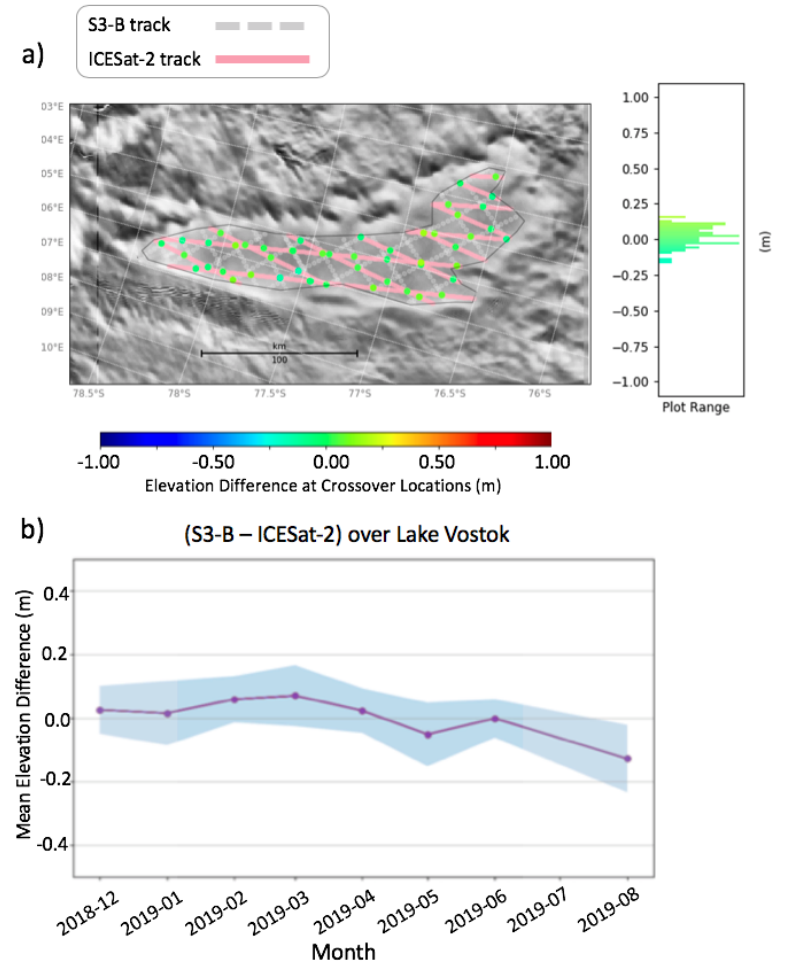
Figure 36. Comparison of S3B with ICESat-2 over Lake Vostok for ( a ) April 2019 and ( b ) the mean monthly difference between December 2018 and August